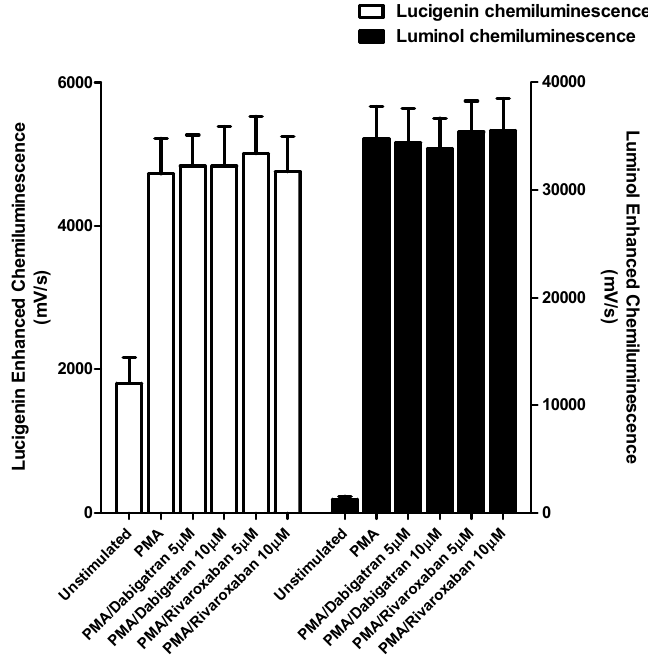
Figure 1. Effects of dabigatran and rivaroxaban (5 and 10 µM) on the PMA-activated lucigenin- and luminol-enhanced chemiluminescence responses of human neutrophils. The results of three different experiments using cells from three different donors are expressed as the mean peak values ± SEMs in mV/s.